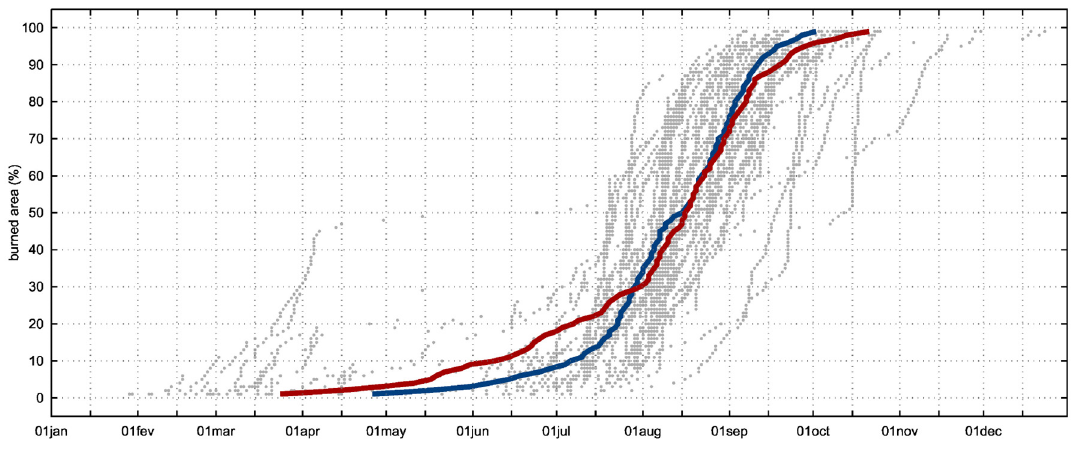
Figure 5. Exceeding dates for successive fractions (1%, 2%, …, 99%) of the annual burned area in each year from 1980 to 2018. Gray dots represent the 99 sequential dates on which each fraction is reached for all years of the study period. Colored lines represent the average dates for the first (1980–1999, blue line) and the second halves (2000–2018, red line) of the study period.